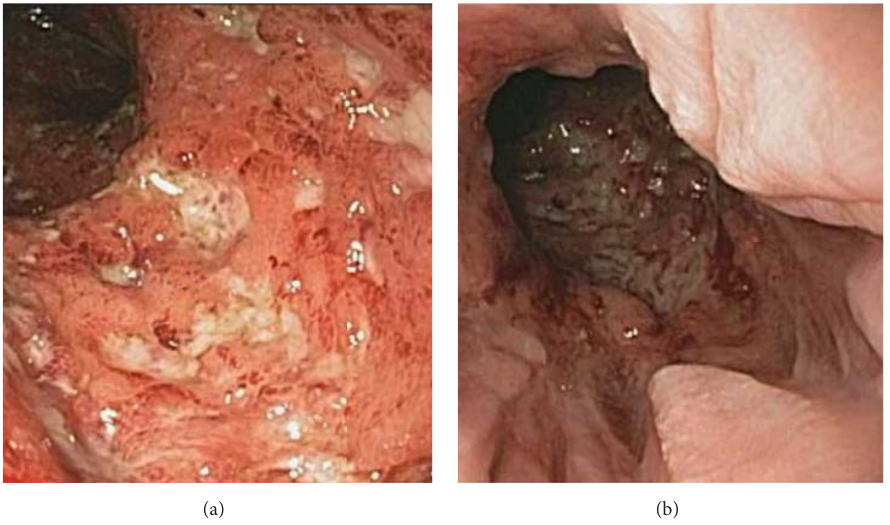
Figure 1: (a) Prepouch ileum. (b) Distal pouch.